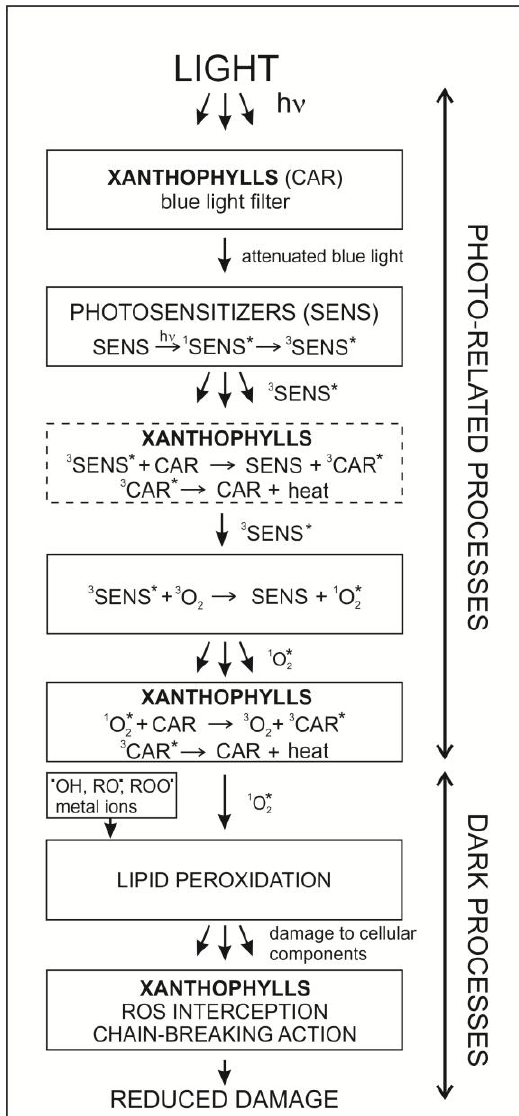
Figure 6. Diagram illustrating processes through which xanthophylls are protecting membranes against oxidative damage. Photo-related and dark processes are actively involved in protecting the retina, while only dark processes are assumed to be active in the protection of brain tissue. The broken rectangles indicate processes that are not yet fully confirmed as involved in protecting the eye retina and are included here as purported processes.